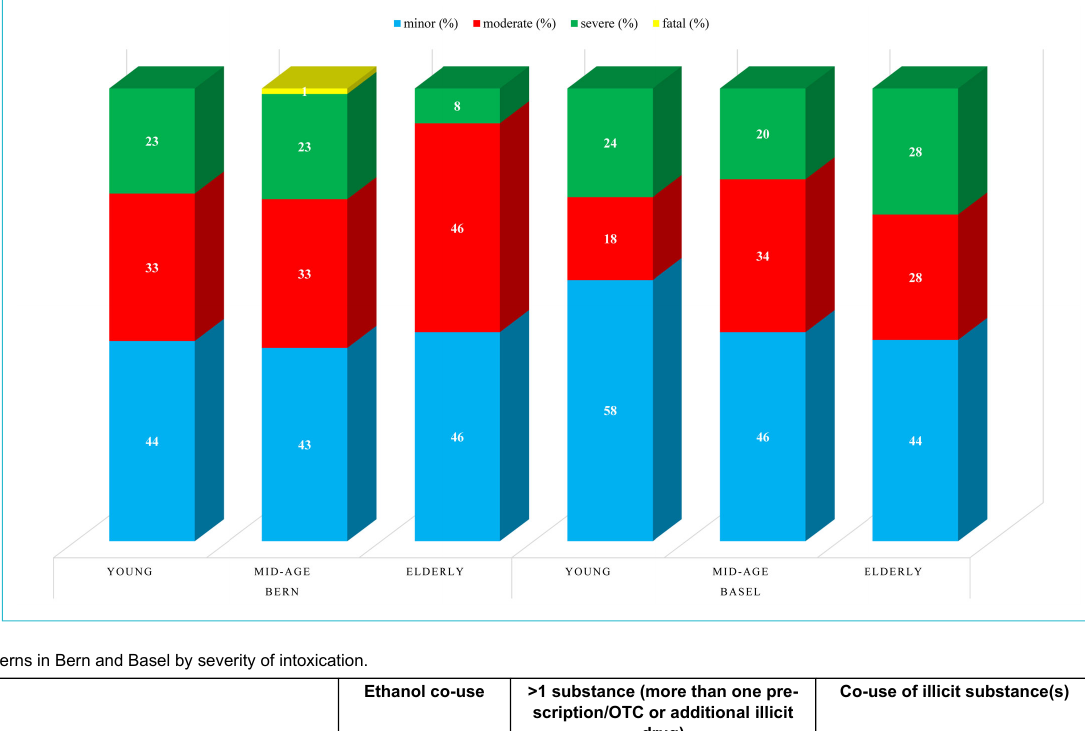
Figure 4: Severity of intoxication by age group in Bern and Basel.